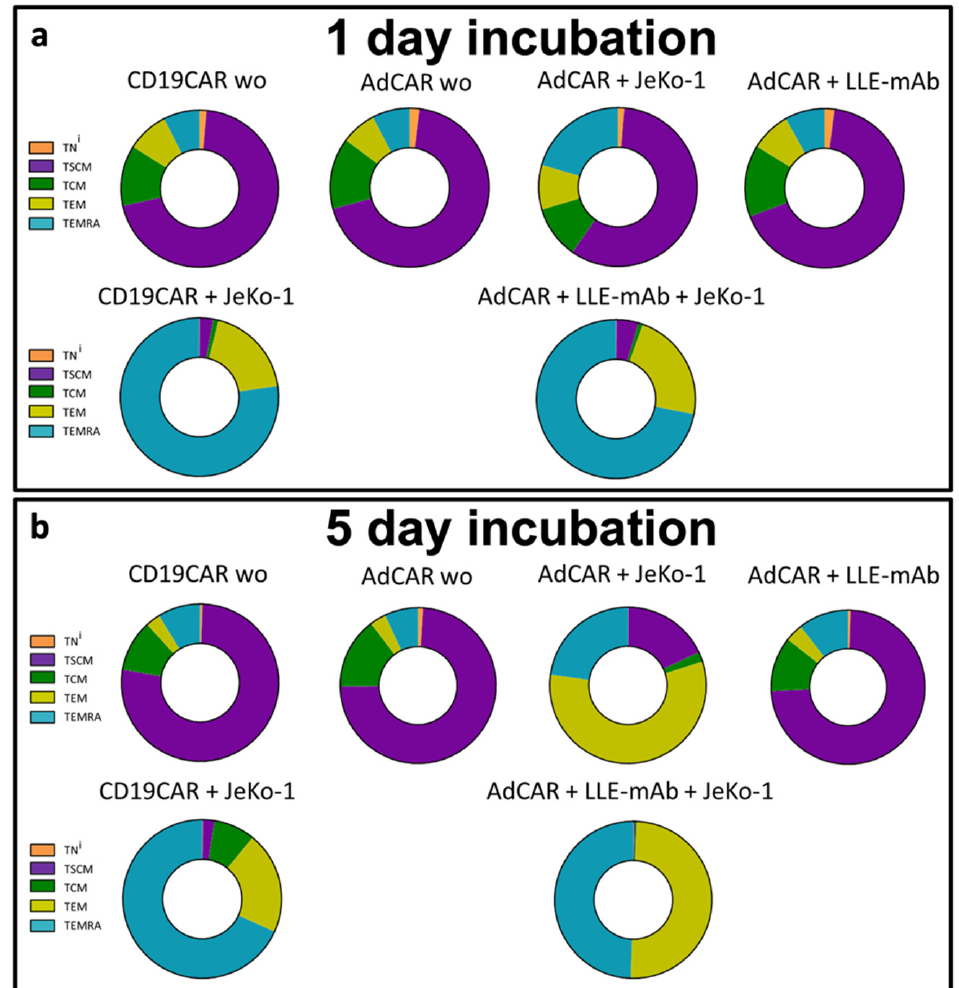
Figure 5. Immunophenotype of AdCAR T cells vs. CD19CAR T cells. CD19CAR T cells were incubated for ( a ) 1 day and ( b ) for 5 days with or without the CD19 + lymphoma cell line JeKo-1. Additionally, AdCAR T cells were incubated for ( a ) 24 h and ( b ) for 5 days with or without the CD19 + lymphoma cell line JeKo-1, and with or without 10 ng/mL LLE-CD19 mAb. Immunophenotypes after incubation were determined by flow cytometry by staining the cell surface markers CD45RA, CD45RO, CD62L, and CD95. Naive T (T Ni ) cells were defined as (CD45RA + /CD45RO − /CD62L + /CD95 − ), stem cell-like memory T cells (T SCM ) as (CD45RA + /CD45RO − /CD62L + /CD95 + ), central memory T cells (T CM ) as (CD45RA − /CD45RO + /CD62L + /CD95 + ), effector memory T cells (T EM ) as (CD45RA − /CD45RO + /CD62L − /CD95 + ), and effector memory T cells that re-expressed CD45RA (T EMRA ) as (CD45RA + /CD45RO − /CD62L − /CD95 + ). Data shown in ( a , b ) represent the mean ± SEM of (n = 3) independent experiments from three different donors.